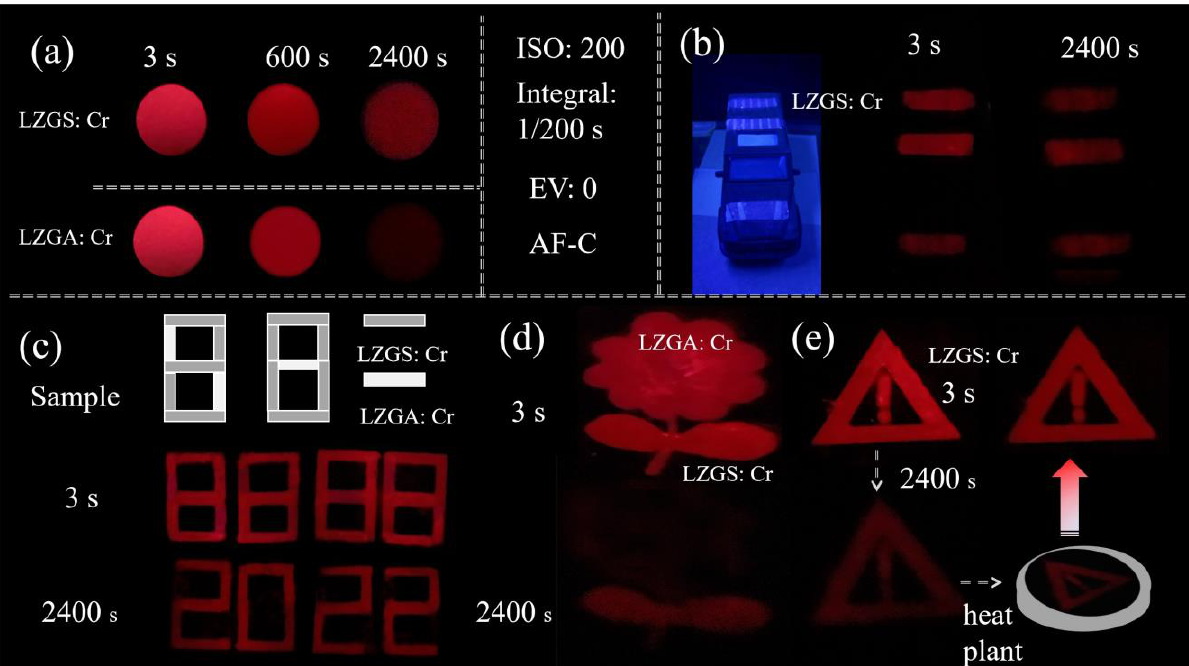
Figure 5. ( a , b ) Digital photos of designed dynamic color images at different times; ( c – e ) encryption application of the luminescence image in the virtual scenario.